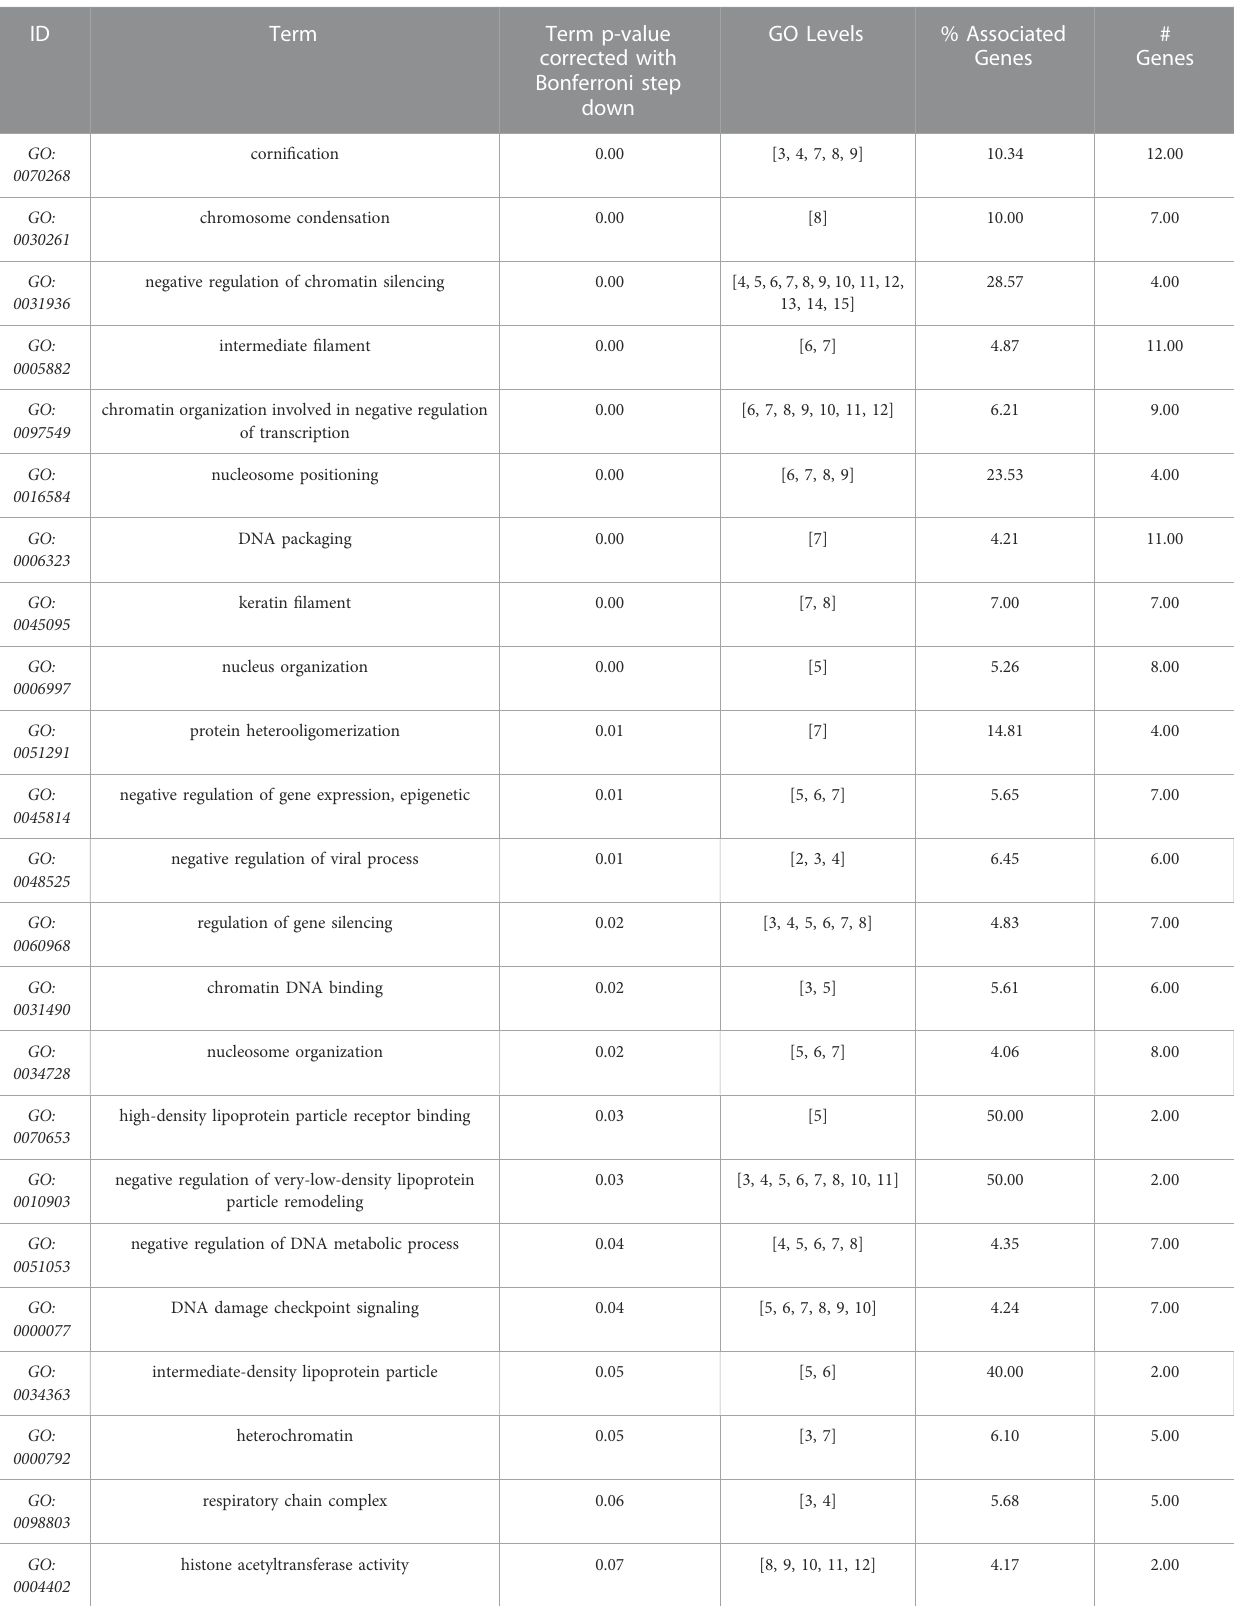
TABLE 4 GO terms (molecular function, cell compartment, and biological process) most signi fi cantly enriched from the 178 proteins differentially expressed between Alport (AS1 and AS3) and control (LT). Data obtained from Cytoscape + ClueGo, only Bonferroni corrected GO terms with p ≤ 0.1) from AS1 and to LT comparison, performed with Cytoscape +